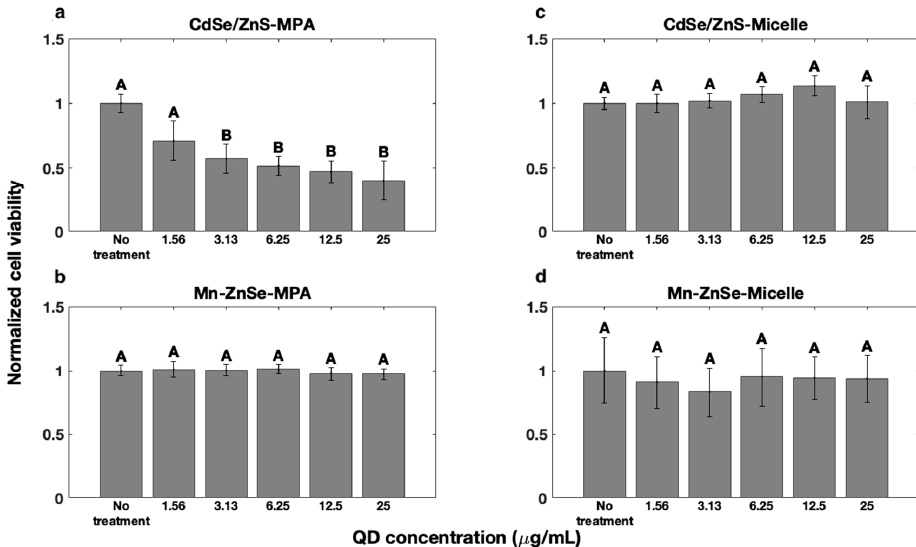
Figure 2. Cytotoxicity of ( a , c ) CdSe/ZnS and ( b , d ) Mn-doped ZnSe QDs coated with ( a , b ) MPA surface ligands or ( c , d ) encapsulated in PS-PEO polymer micelles as a function of dose as measured by the MTT assay. Bars connected by different letters display statistically significant differences. Thus, bars connected by B are statistically different from controls samples (i.e., samples connected with A).